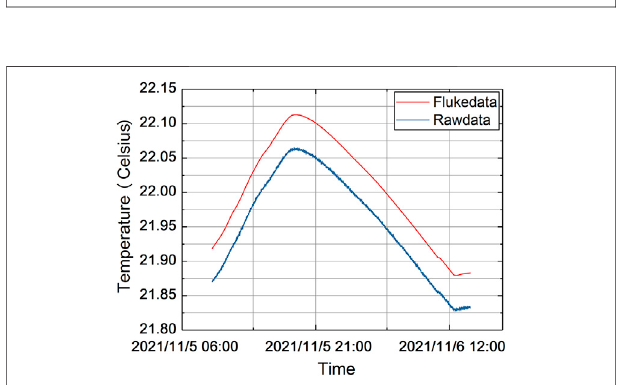
FIGURE 7 | Comparison of raw test data.